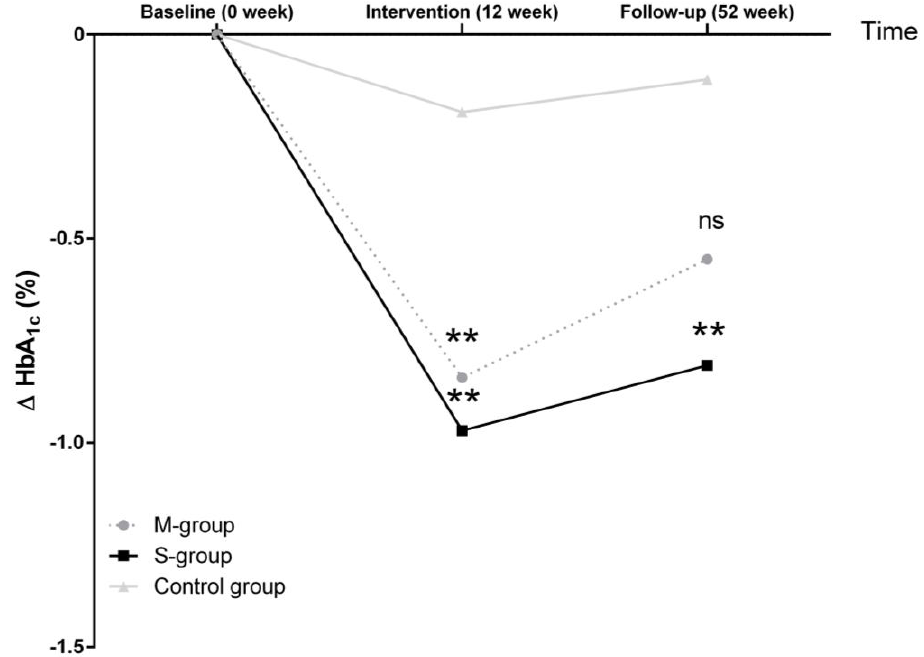
Figure 3. Change of glycemic control after 12 weeks of intervention and 52 weeks of follow-up. At baseline, M-, S- and control group were not significantly different, however, 12 weeks of diet intervention led to reductions in HbA1c in both intervention groups in comparison to the control group. Compared to controls, only the S-group showed a significant difference in HbA1c after 52 weeks of follow-up. Analyses of variance with repeated measures were performed to determine differences between groups; ns, not significant; ** p < 0.01 vs.